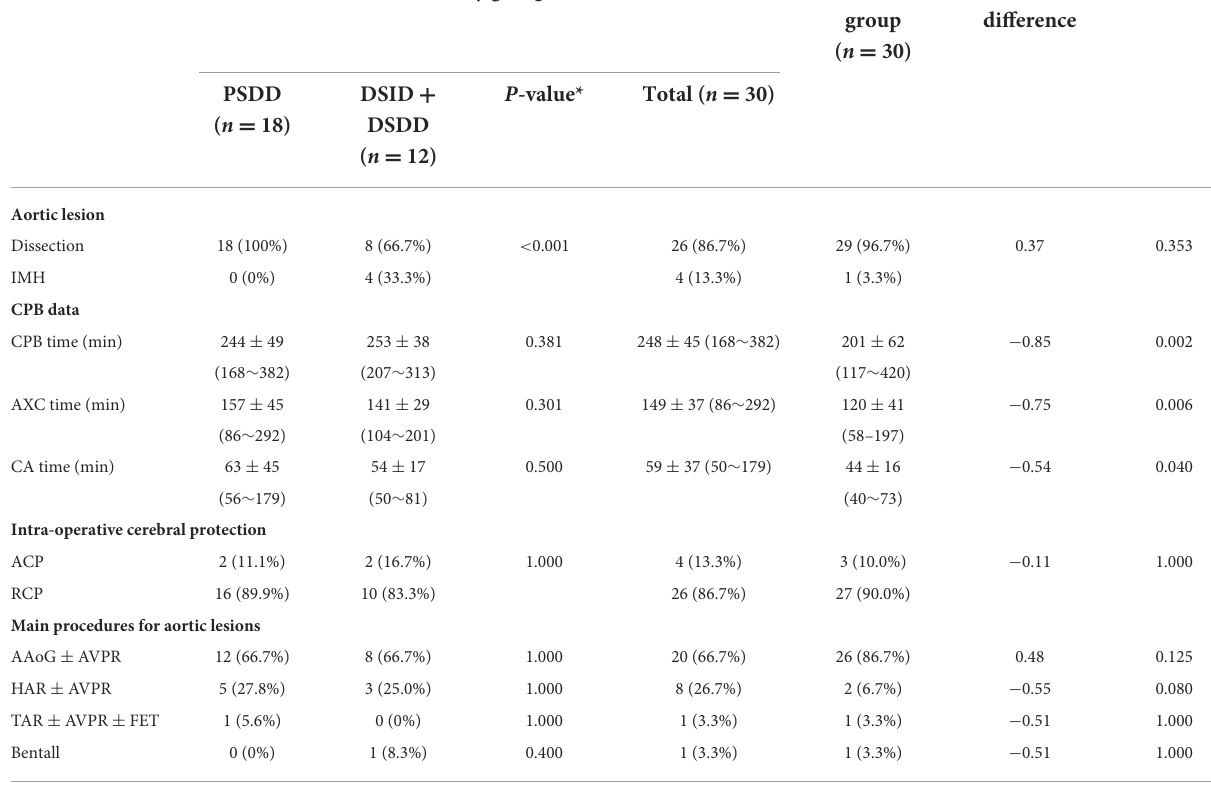
TABLE 2 Intra-operative